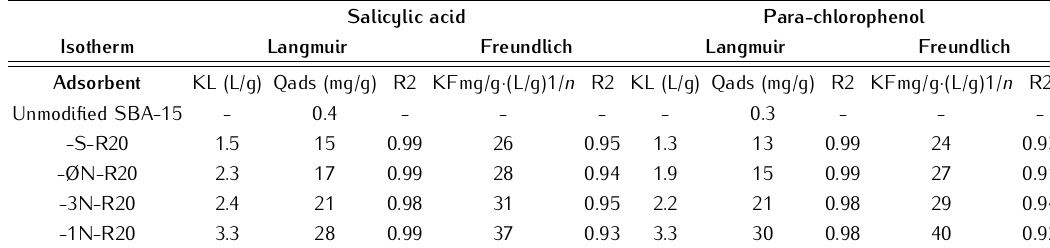
Table 5. Values of the calculated constants of adsorption isotherms.